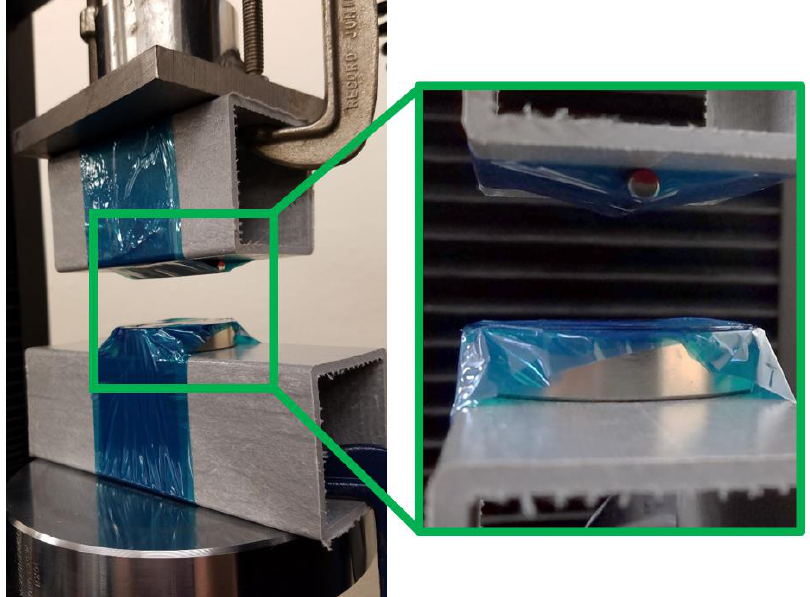
Figure 12. Marking the poles of the neodymium rod magnet so that when attached to the upper leg, the opposite poles face each other between the disk magnet and the rod magnet to ensure maximum attraction and no repulsion.